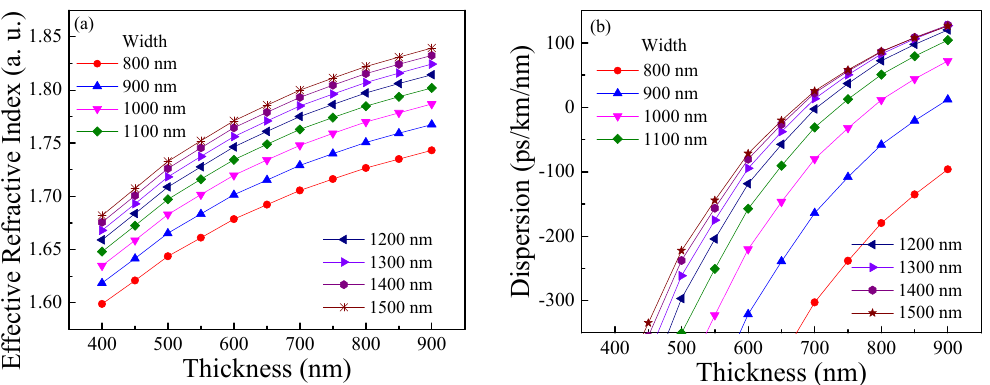
Figure 2. ( a ) The effective refractive index, and ( b ) the dispersion of PECVD silicon nitride waveguide with different widths and thicknesses.